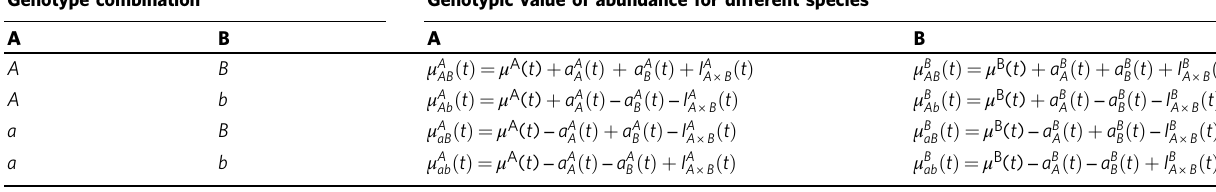
Table 1 Overall genotypic values of genome – genome combinations at a QTL and their decomposition into different components for two coexisting bacterial (haploid) species A and B Genotype combination Genotypic value of abundance for different